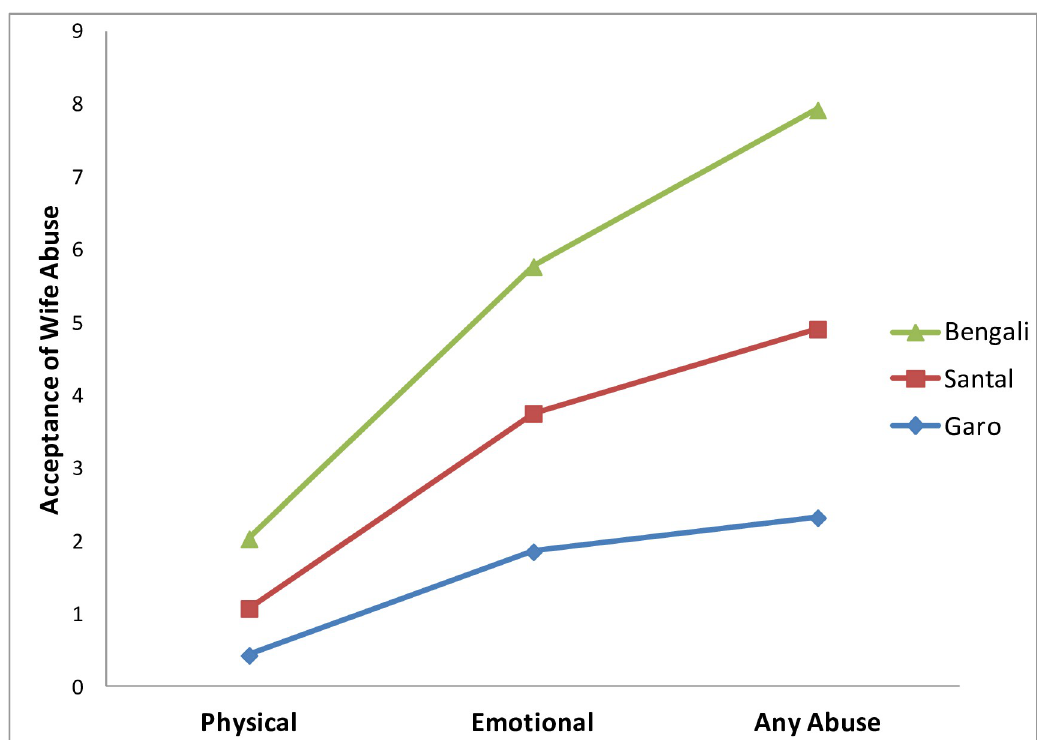
Fig 1. Predicted means plot of the acceptance of wife abuse events by